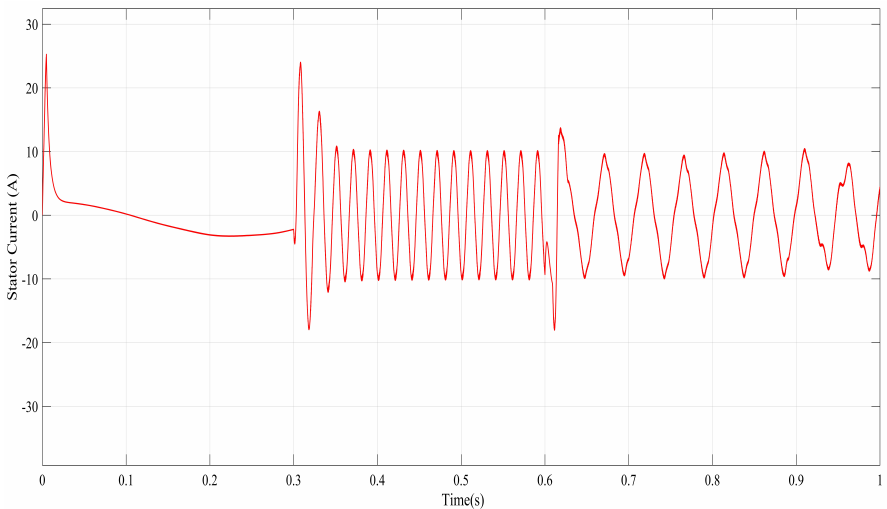
Figure 14. Stator current response to varying